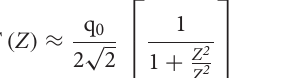
FIGURE 3 | (A) Diffuse reflectance spectra of the MoS 2 nanoflakes. (B) Tauc’s plot of ( α h ν ) 2 as a function of photon energy (h ν ) for the MoS 2 nanoflakes.